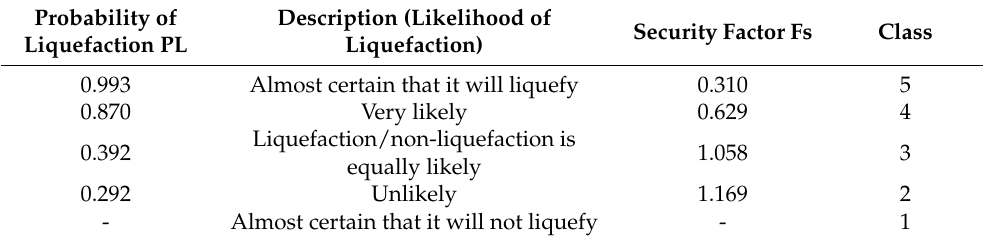
Table 6. Soil liquefaction probability proposed by Chen and Juang [38] for the city of Portoviejo.